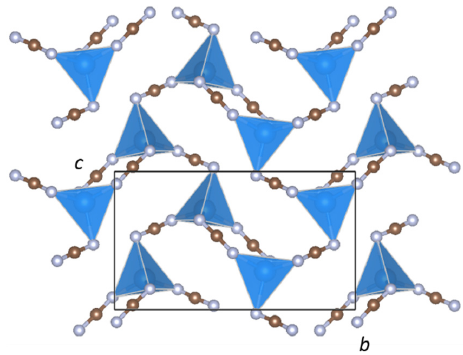
Figure 5. Two-dimensional [Zn(NCN) 2 ] network connectivity in BaZn(NCN) 2 .